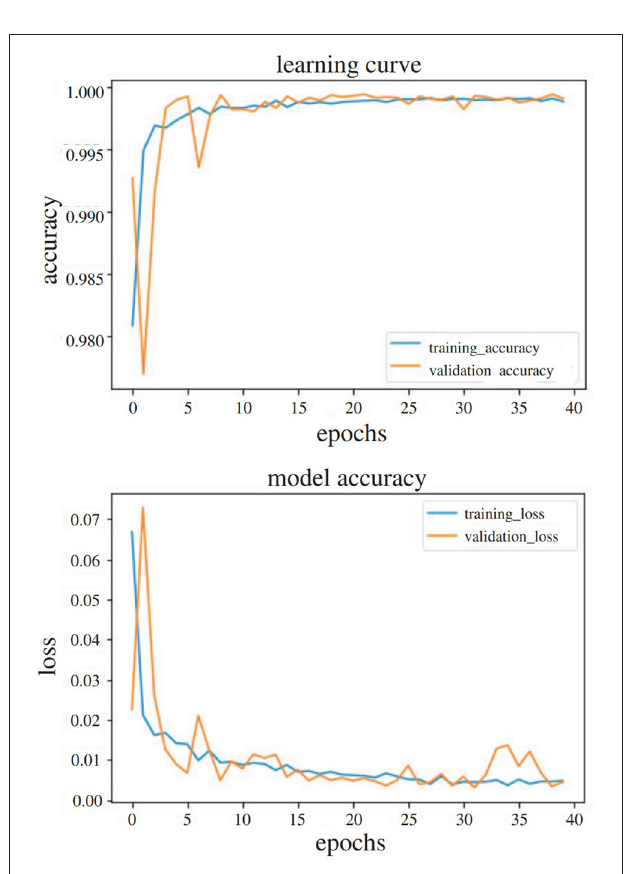
FIGURE 7 | Accuracy and loss diagrams of the experiment with transfer learning, trained for 40 epochs in